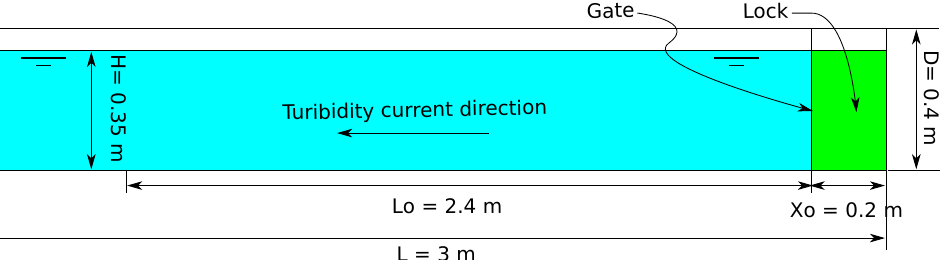
Figure 2. Schematic representation of the tank used in the experiments. The dimensions of the lock and the tank and the water depth are shown. Table 1. Main parameters of the experimental runs.